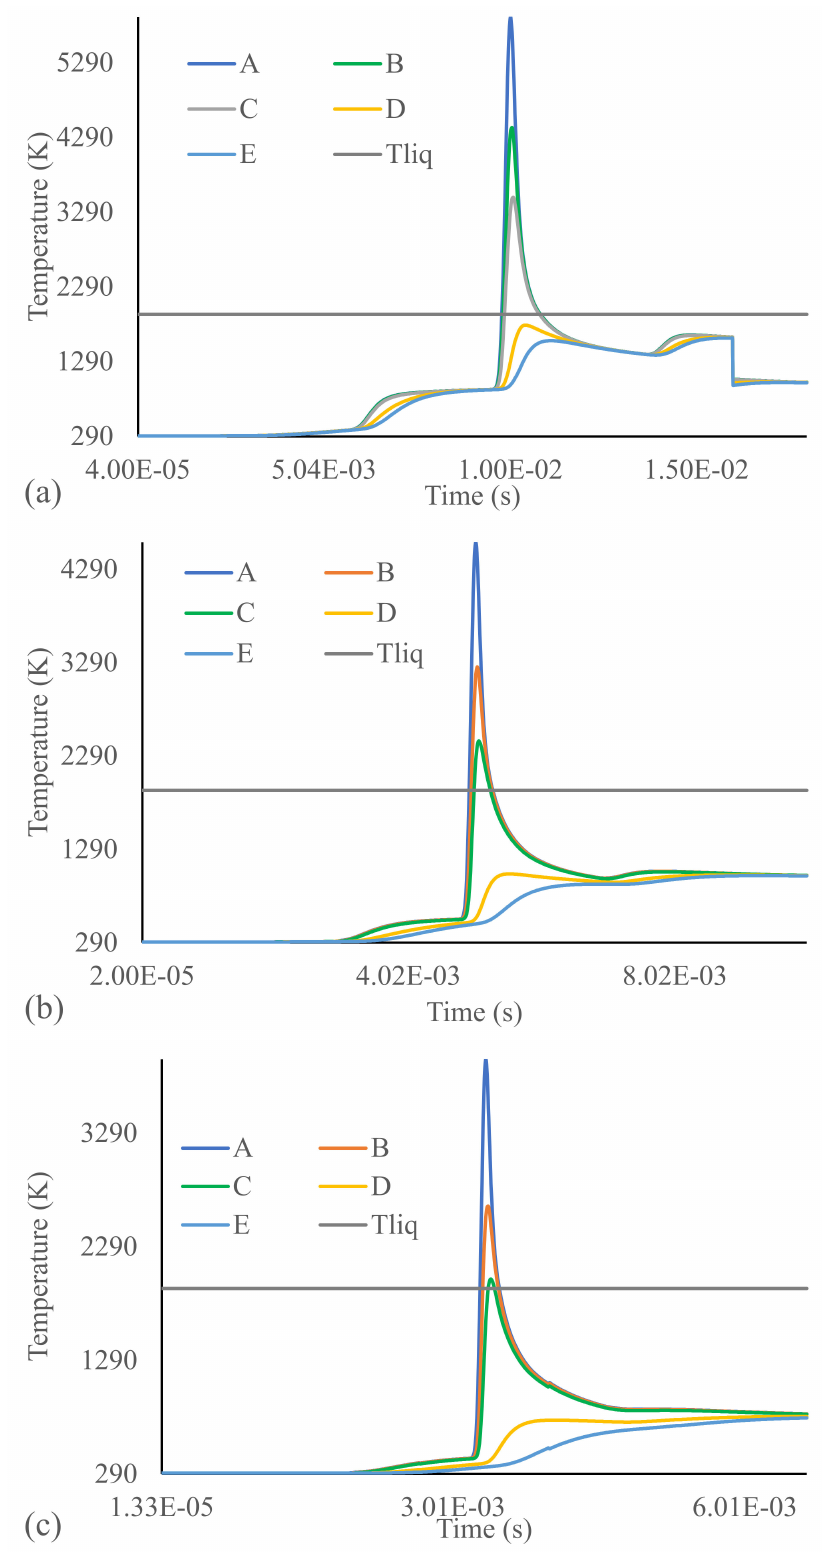
Figure 6. Variation of temperature of A, B, C, D, E. (Tliq is liquidus temperature) ( a ) P = 100 W, sp = Y, v = 0.5 m/s, ( b ) P = 100 W, sp = Y, v = 1.0 m/s, ( c ) P = 100 W, sp = Y, v = 1.5